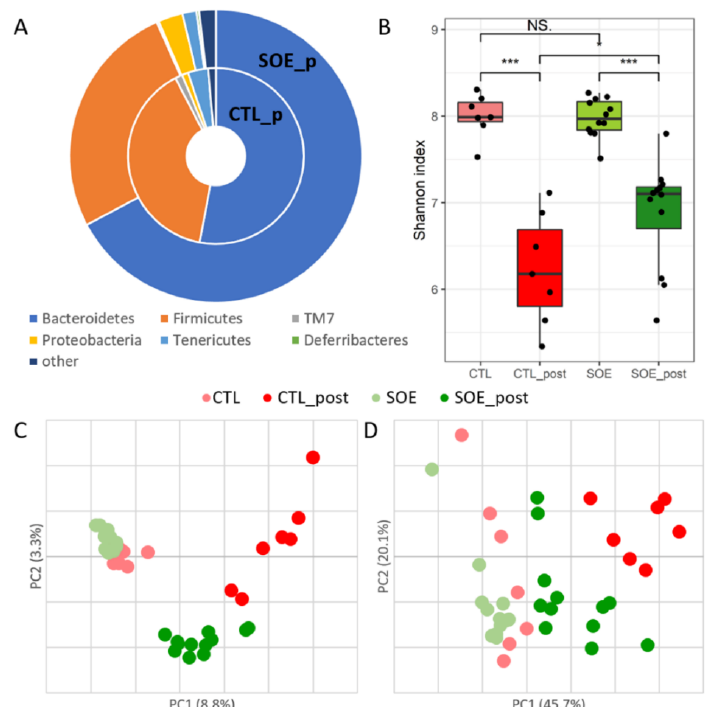
Figure 1. Fecal microbial composition of C57BL/6 mice is affected by soybean oil (SO)-based emulsion (SOE) supplementation. Bacterial composition was assessed by Illumina MiSeq 16S rRNA gene sequencing of fecal DNA, collected preceding (at the age of 8 weeks) and following (at the age of 12 weeks) the study period. ( A ) Phylum level relative abundance of SOE supplemented mice (inner circle) and control mice (outer circle) following the experimental period. Deferribacteres (scarcely seen in green) were found at low abundance in SOE group (0.3%). ( B ) Shannon α -diversity index of control (red) and SO (green) treated mice preceding (light colors) and following (dark colors) the experiment period. PCoA based on ( C ) unweighted and ( D ) weighted UniFrac measures. Every dot represents the entire microbiota of a single mouse. In total, 12.1% and 65.8% of total variance is explained by PCs 1 and 2 of unweighted and weighted UniFrac measures, respectively. * p < 0.05, *** p < 0.001.